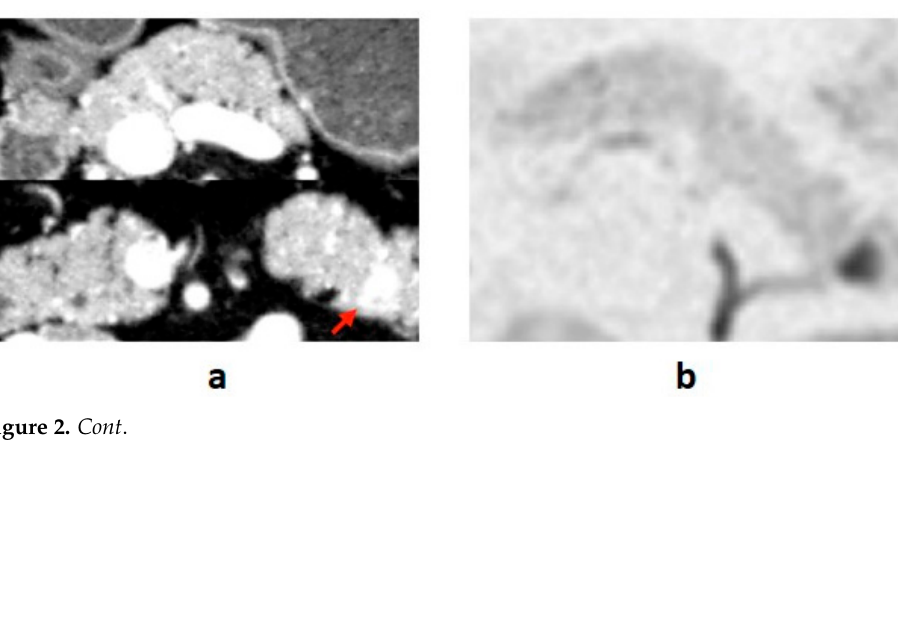
Figure 2. ( a ) Contrast-enhanced computed tomography (CT): a mass lesion with early hyperen- hancement is seen in the tail of the pancreas (red arrow), but there are no other obvious lesions. ( b ) Diffusion-weighted magnetic resonance imaging (MRI): the mass in the pancreatic tail shows re- duced diffusion. ( c ) Endoscopic ultrasound (EUS): in addition to the mass ( ☆ ) revealed by CT/MRI, many small hypoechoic masses are observed (white arrow). ( d,e ) Resected specimen: the main lesion ( ☆ ) is an 11 mm neuroendocrine neoplasm (NEN) G1, but multiple tumors with diam- eters of 1–3 mm are observed in the surrounding pancreas (white and yellow arrow) (20×). They are multiple NENs associated with multiple endocrine neoplasia type 1 (MEN-1). 5. Role of EUS Elastography Elastography measures the stiffness of the target lesion. Various types of elas- tography devices utilize different mechanisms. In the clinical setting, strain and shear wave elastography are mainly used for pancreatic diseases. The evaluation methods of